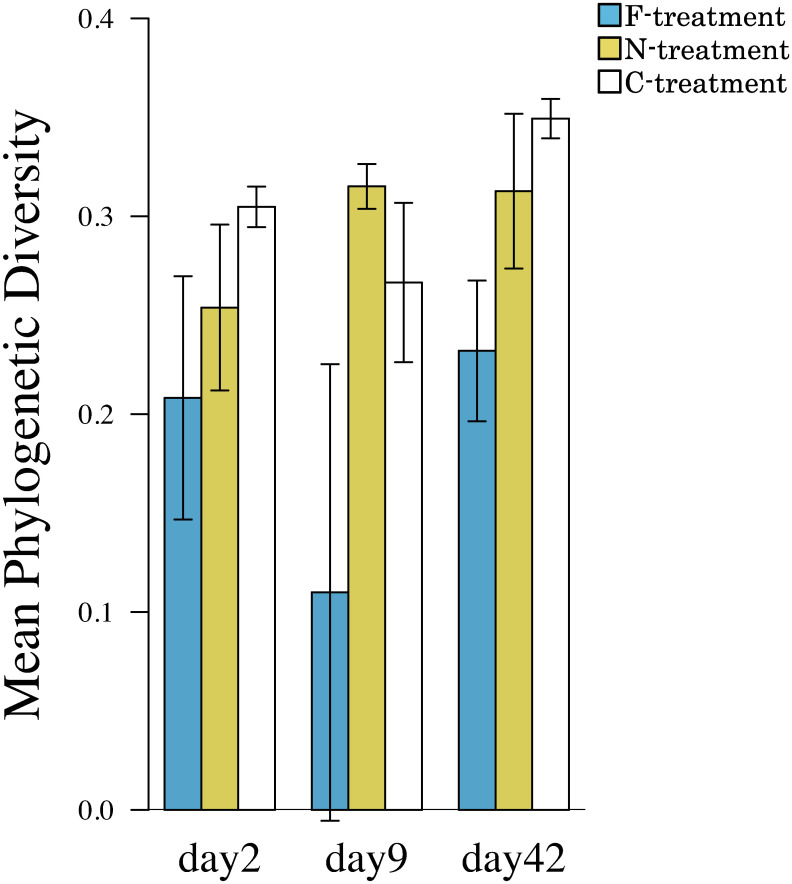
The Mean Phylogenetic Diversity (MPD) of ciliophoran assemblages in each of the three treatments.The vertical bar is the SD on the mean.